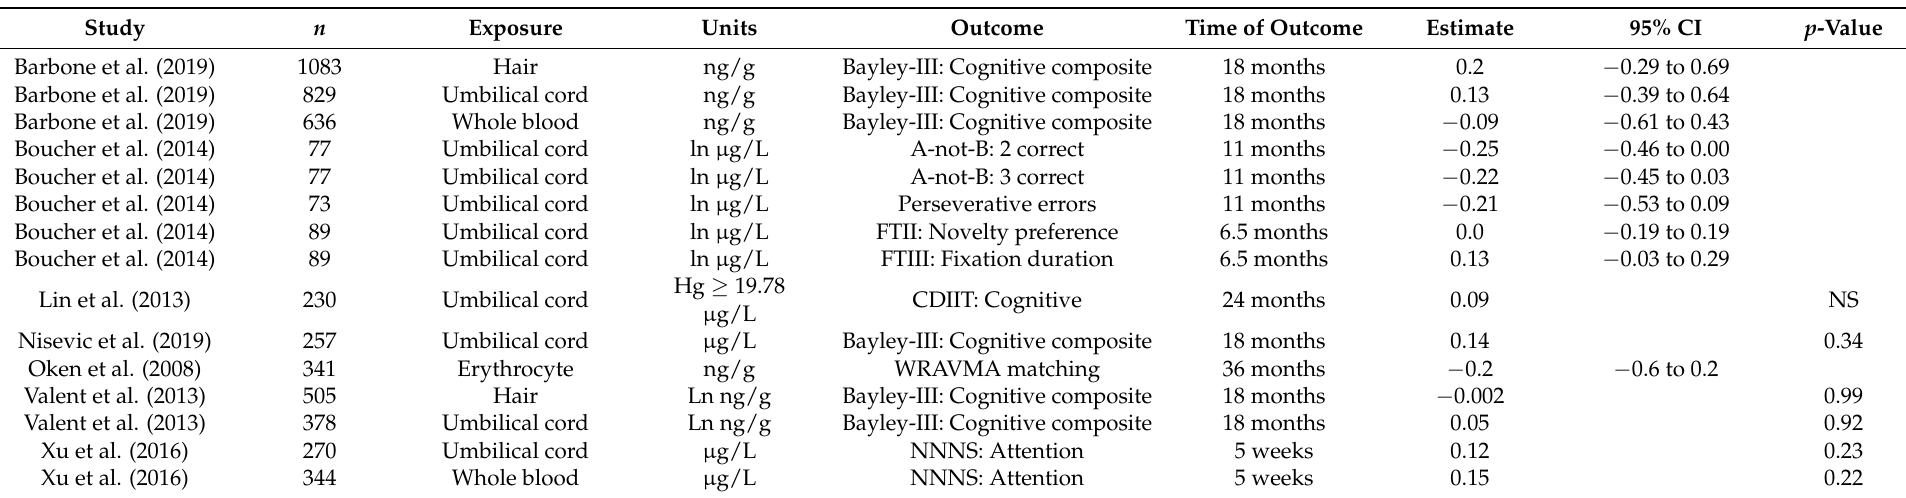
Table 5. Results from studies identified as high quality which measured cognition ( n =